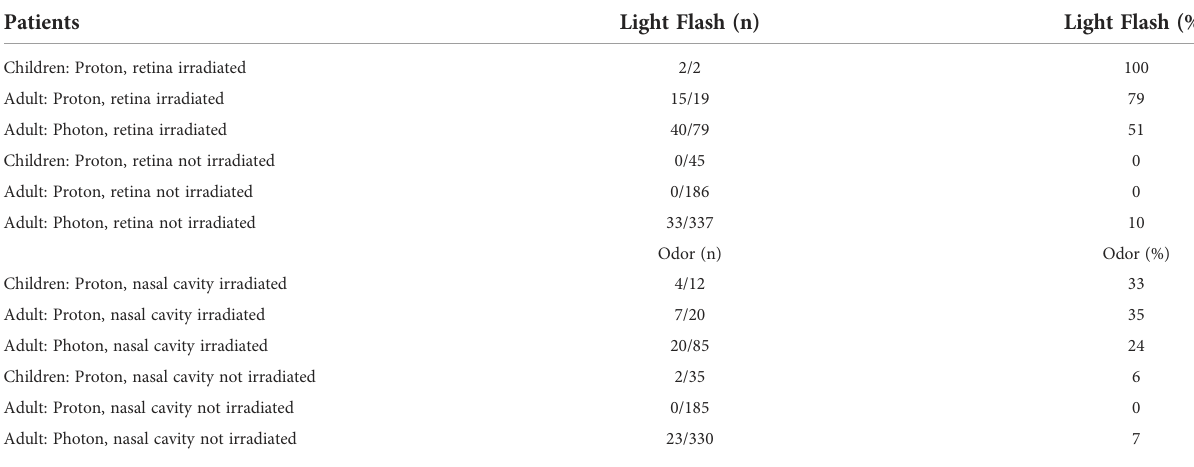
TABLE 4 Comparison of results for pediatric and adult patients.